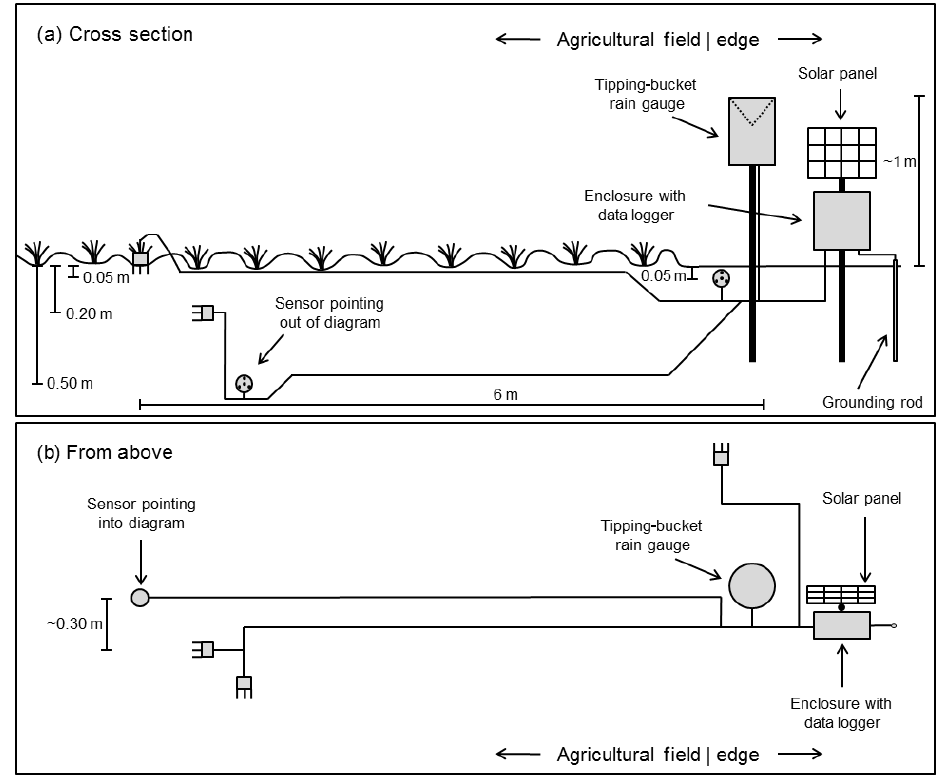
Figure 4. General configuration of four-probe soil moisture